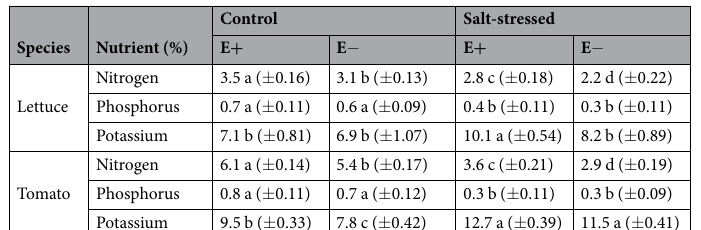
Control Salt-stressed Species Nutrient (%) E + E − E + E −